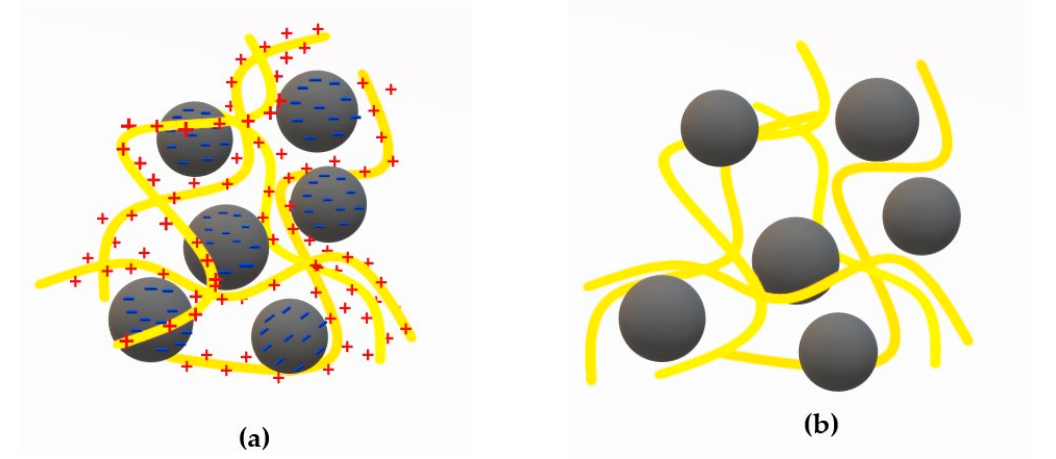
Figure 2. Scheme of flocculation mechanisms (the curved lines represent polymer chains adsorbing to the spherical colloidal particles): ( a ) charge neutralization; and ( b ) polymer bridging.